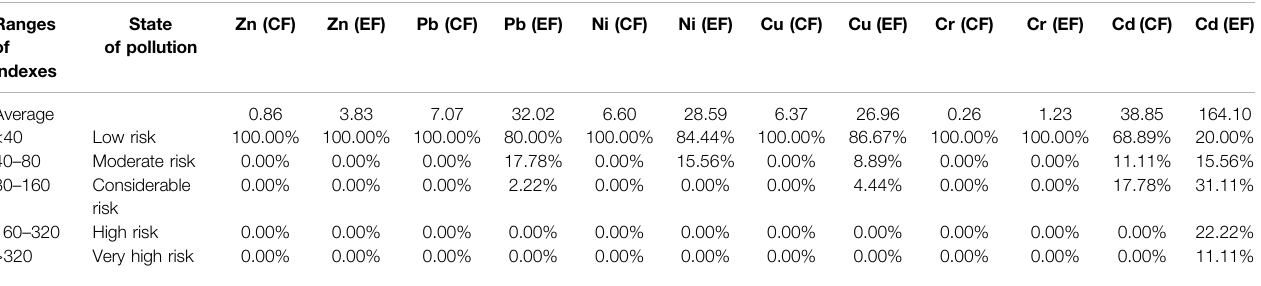
TABLE 8 | Evaluation results in the potential ecological riskindex ofan individual element (Eri) withEF or CF percentage (%) in the surface sediments ofthe Jian and Moyang rivers. Ranges of indexes Average Moderate risk